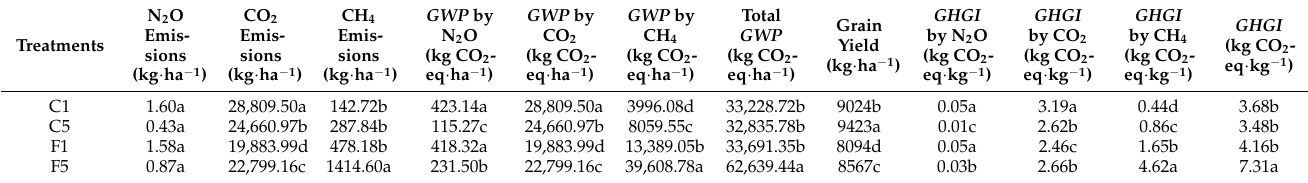
Table 4. Global warming potential and greenhouse gas intensity in each